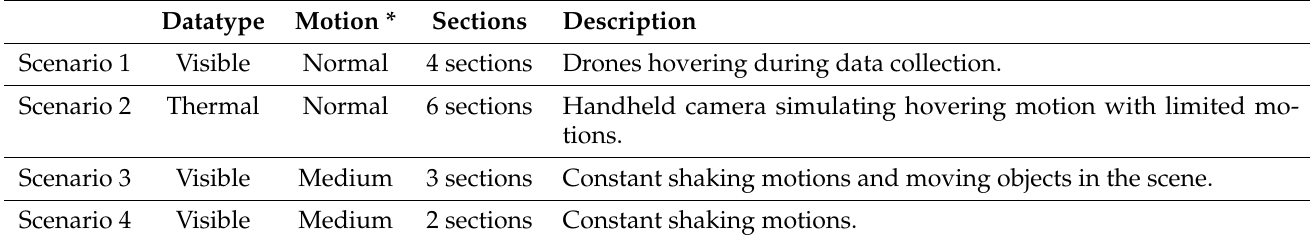
Table 4. Details of scenarios in the Experiment C: * the motions are set to normal and medium. The medium motions are constantly shaking to investigate the resistance of stabilization methods.